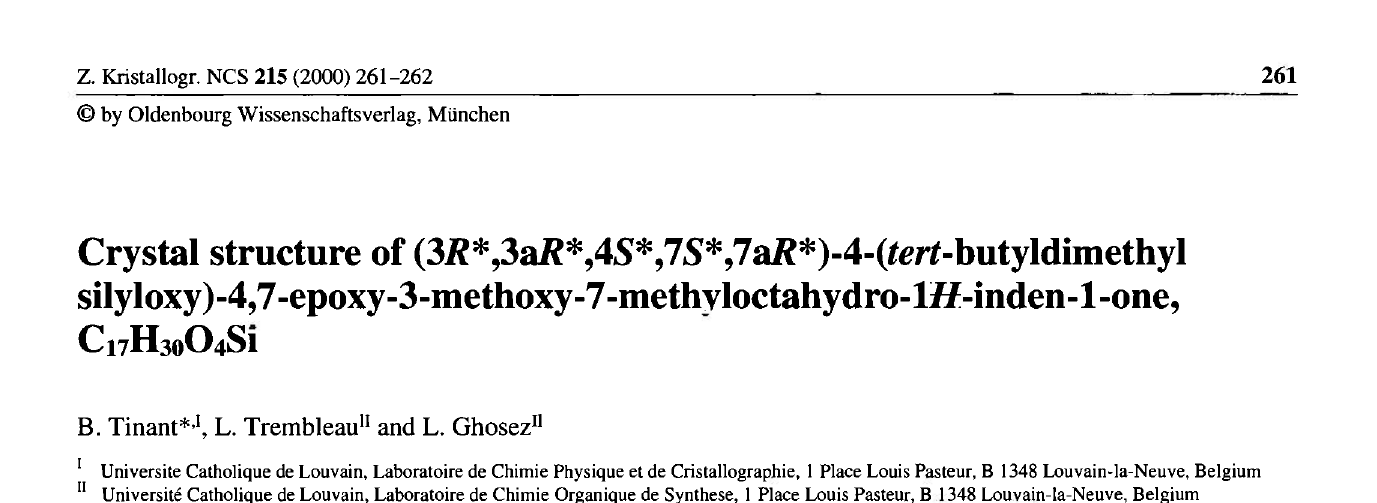
Table 1. Data collection and handling.